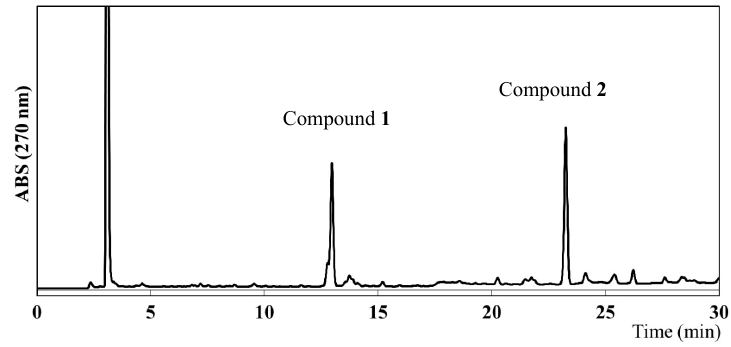
Figure 3. HPLC chromatogram of the ethanol extract of Algerian propolis 1 (EEAP1). Compound 3 was obtained as an amorphous solid and its molecular formula was determined to be C 25 H 32 O 4 by HR-ESIMS ( m/z 419.2194 [M+Na] + calculated for C 25 H 32 O 4 Na, 419.2198; Figure S3). The 1 H NMR spectrum of 3 in acetone- d 6 showed signals corresponding to aromatic protons ( δ 7.50–8.00), a methoxyl group ( δ 4.06), and three methyl groups ( δ 1.50–1.70; Figure S4). The 13 C NMR spectrum showed 25 signals attributable to a methoxy group ( δ 62.4), aromatic or olefinic carbons ( δ 102.4–136.4), two aromatic/olefinic carbons conjugated with a hydroxyl group ( δ 153.5 and 163.4), and a carbonyl carbon ( δ 163.9; Figure S5). The 2D NMR spectra of 3 revealed the presence of a coumarin struc- ture conjugated with a farnesyl group (Figures S6 and S7). Hence, a correlation between methoxyl protons ( δ 4.06) and an aromatic carbon conjugated with a hydroxyl group ( δ 163.4) indicated the presence of an enol in the coumarin moiety. Consequently, 3 was confirmed to be the enol form of methylated ω -hydroxyferulenol (Figure 4).